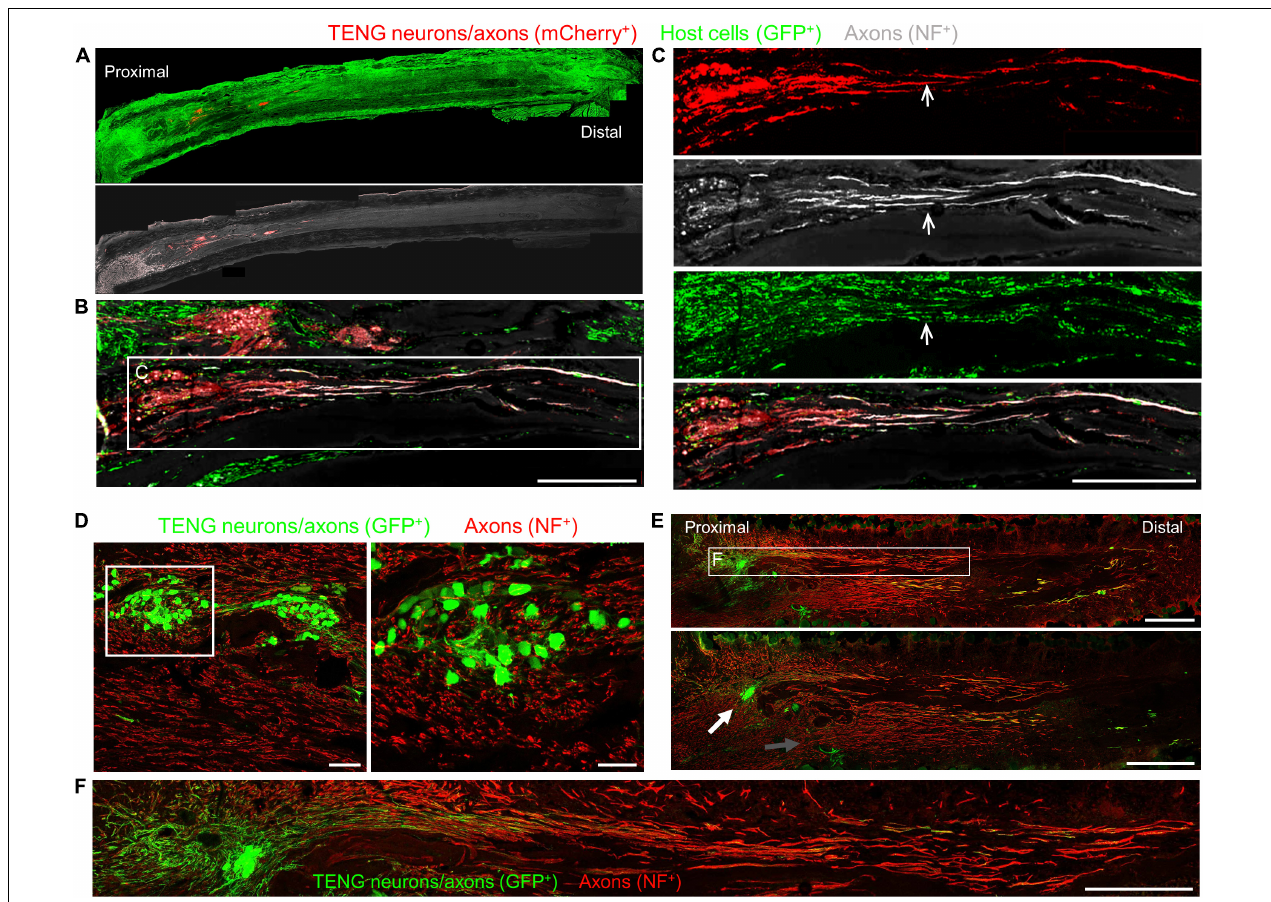
FIGURE 3 | TENG Survival, Maintenance of Architecture, and Mechanism-of-Action following Allogeneic Transplants in Rats. Longitudinal sections across the graft zone at 2 weeks post-implant. (A–C) Implant of mCherry + TENGs into GFP + host rats to discriminate TENG neurons/axons (red) versus host cells/axons (green). (A) Full-width longitudinal section and (B) zoom-in of region of interest showing robust and directed host axon regeneration and support cell infiltration directly along TENG axon tracts. (C) Region-of-interest showing individual channels depicting TENG neurons/axons (red), axons (purple), all host cells (green), with overlay. Arrow depicts TENG axons co-localized with host axons, suggesting directed growth. Scale bars (A) 500 µ m; (B) 250 µ m; (C) 300 µ m. (D–F) GFP + TENG neurons/axons into wild-type host rats. (D) Surviving TENG neurons/axons (green) exhibiting healthy morphology (scale bar: left, 100 µ m; right 50 µ m). (E,F) A nerve repaired using a TENG (GFP +) labeled with SMI31 (red) to show host axon regeneration. (E) Living TENG neurons and axons (green) were found across the entire nerve graft. TENG neurons/axons were placed off-center to demonstrate that host axons have a preference to follow the path created by the stretch grown axons: the white arrow points out the altered direction of host axon growth through the main cluster of TENG cell bodies and axons; the gray arrow points out the natural axon regeneration trajectory straight out from the proximal stump (scale bars: 1000 µ m). This suggests that TENG neurons/axons actively direct and guide host axon regeneration. (F) Region-of-interest showing dense bundles of host axons that were intertwined with and appeared to grow directly along TENG axons. Collectively, these images provide evidence of a new mechanism of nerve regeneration: axon-facilitated axon regeneration (AFAR) denoted by host axon regeneration directly along tissue engineered axon